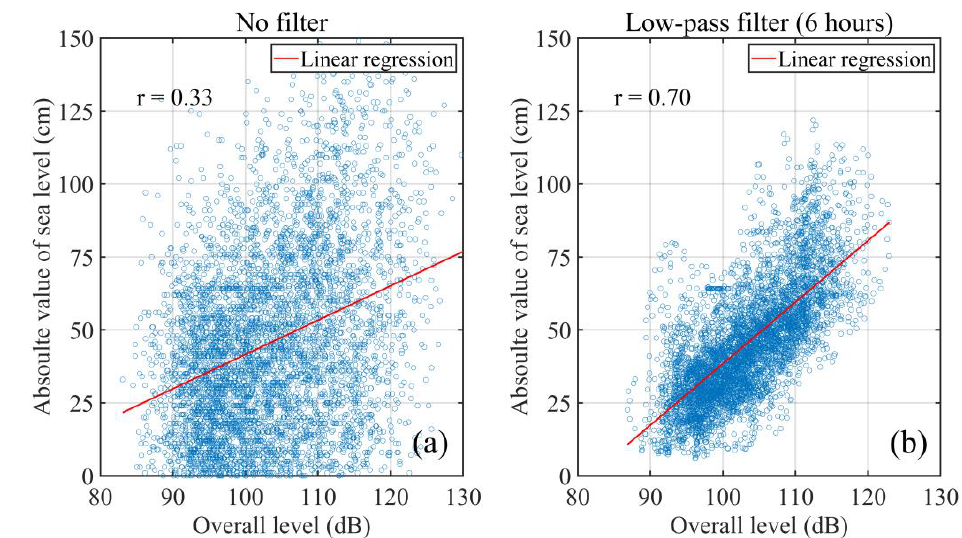
Figure 6. Correlation between the absolute value of sea level and overall underwater noise level ( a ) without and ( b ) with low-pass filtering at 6 h.